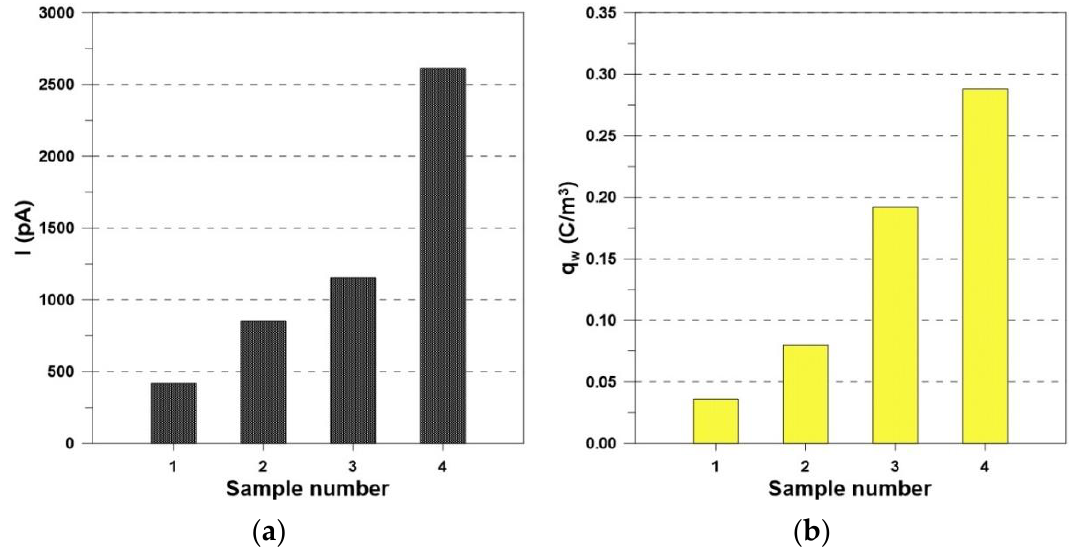
Figure 7. ( a ) Electrification current and ( b ) volume charge density q w of: 1—fresh Trafo EN, 2—aged Trafo EN, 3—Nycodiel 1255, 4—20% (SE)—80% (fresh MO) mixture.